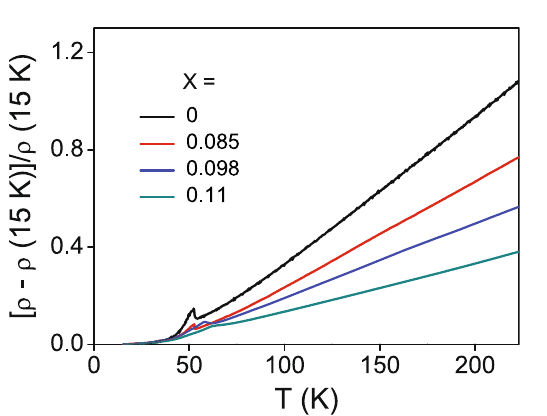
Figure 5. Temperature dependence of the quantity [ ρ (T) − ρ (15 K)]/ ρ (15 K) in the temperature range 15 K–230 K for x = 0.000, 0.085, 0.098 and